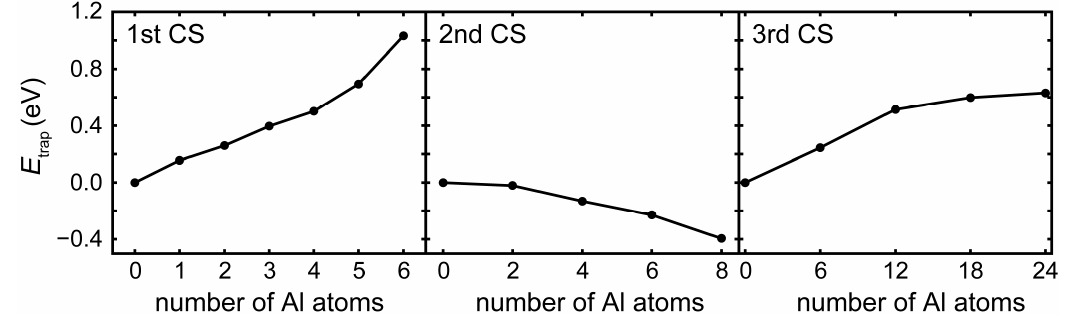
Figure 2. Hydrogen trapping energy E trap as a function of the local atomic environment with respect to the amount of Al atoms in the first, second, or third coordination sphere (CS) around a single interstitial H atom in a 3 × 3 × 3 supercell of fcc-Fe. Al atoms occupy Fe sites in the host matrix. The energies are defined according to Equation (2).